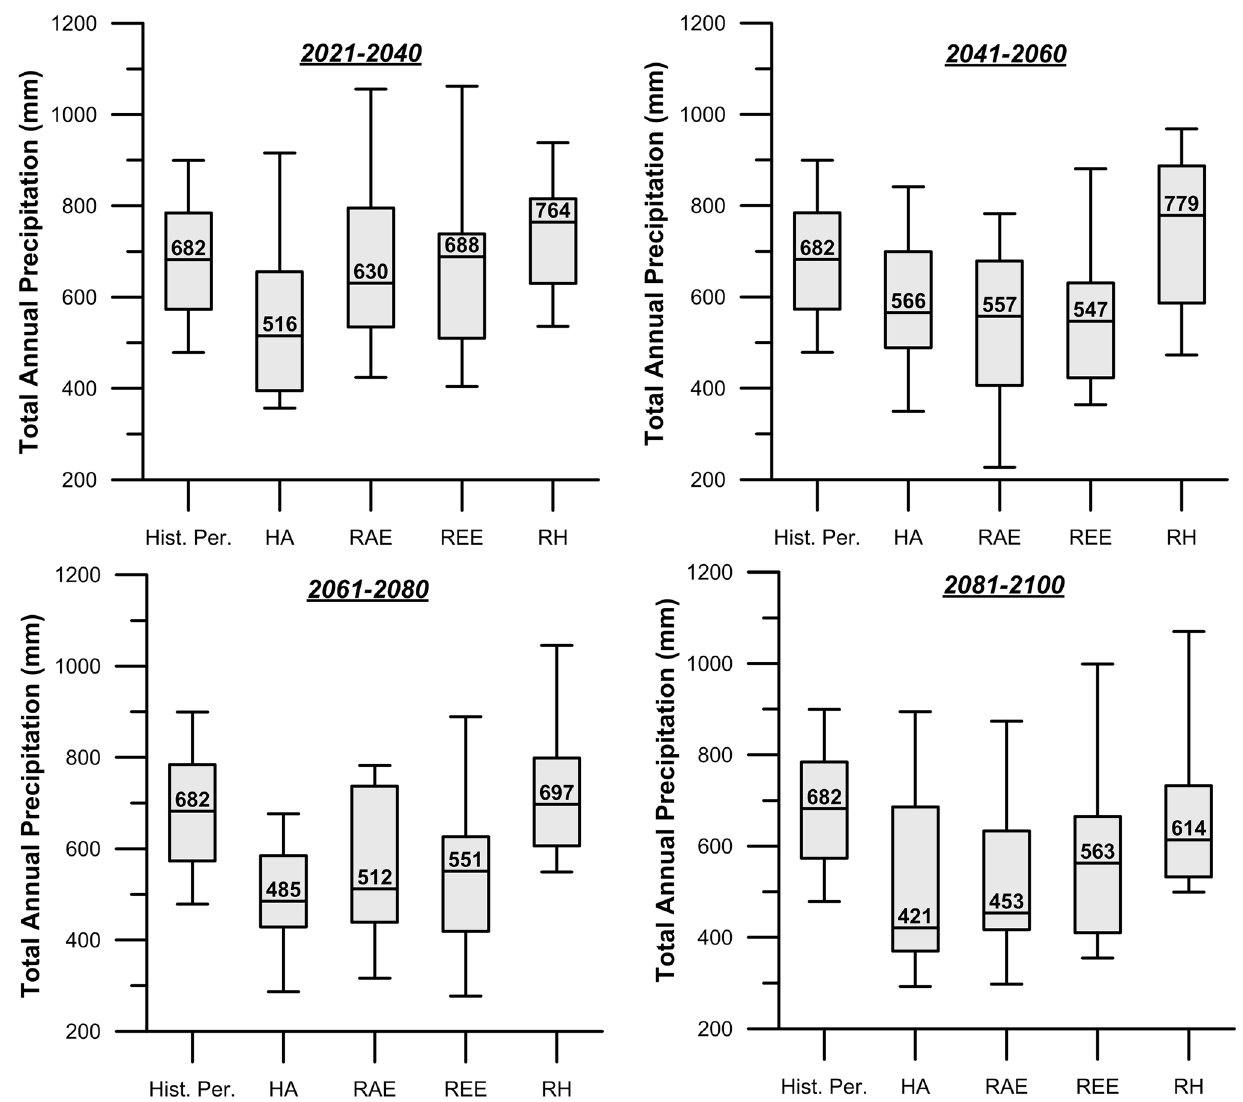
Fig. 3 Box-plots of total annual precipitation variation according to results from the four RCM–GCM combinations for the periods